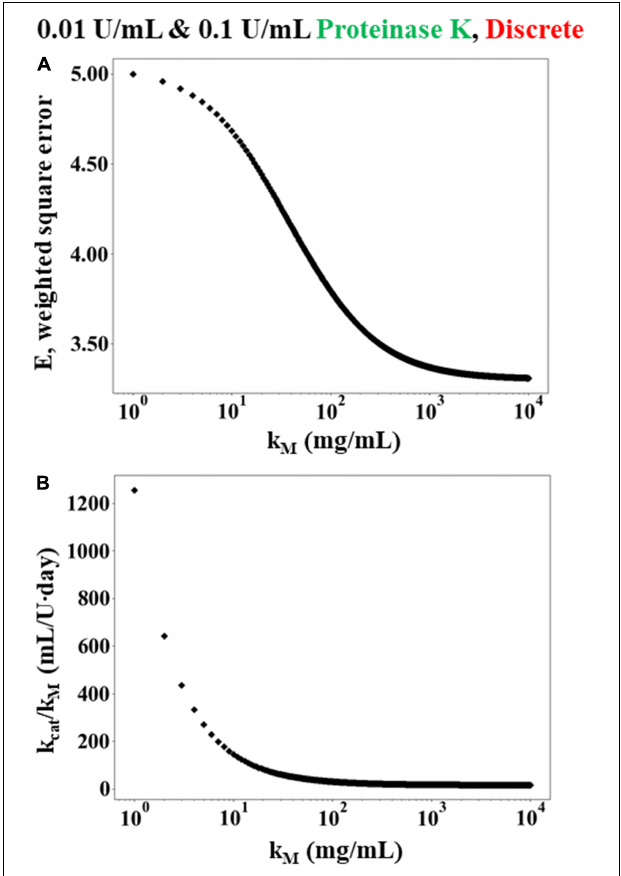
FIGURE 2 | Simulated results of weighted least squares analysis using the Michaelis-Menten rate law for data obtained from discrete experiments using 12 h WA silk sponges immersed in 0.01 and 0.1 U/mL Proteinase K. (A) The minimum error E plotted as a function K M . The value of E